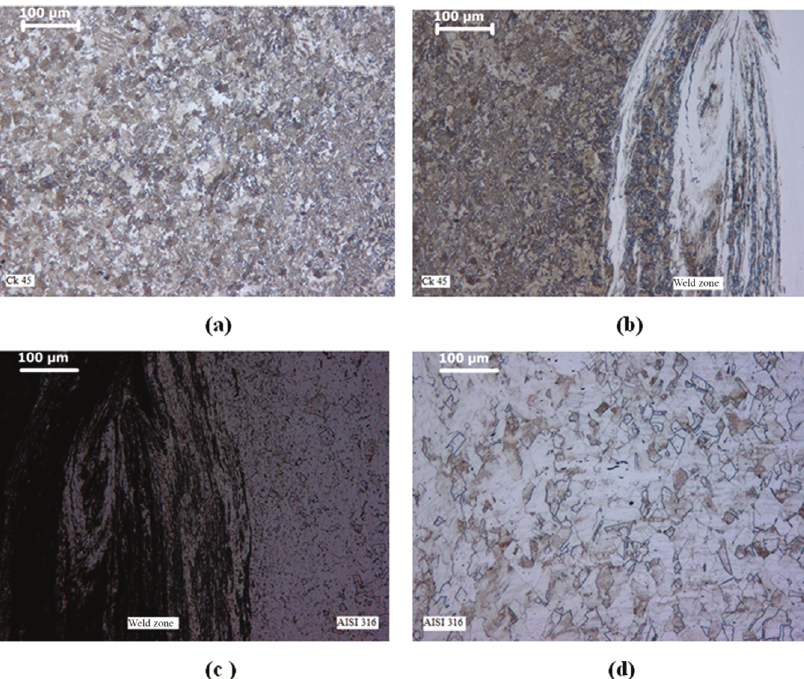
Figure 5: Optic microstructures of welded sample in the different zones.